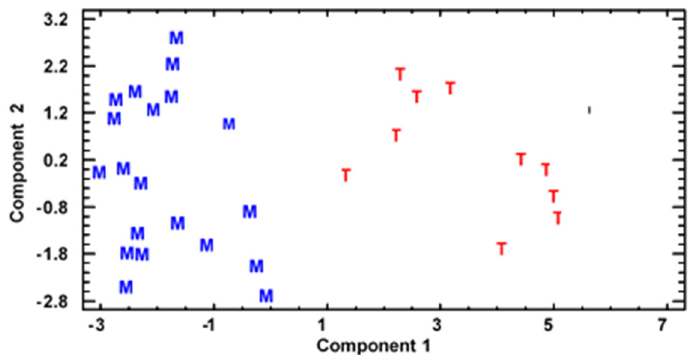
Figure 2. Dispersion plot of principal components 1 and 2 for HPLC data obtained for Mencia (M) and Alicante Bouschet (T) wines.